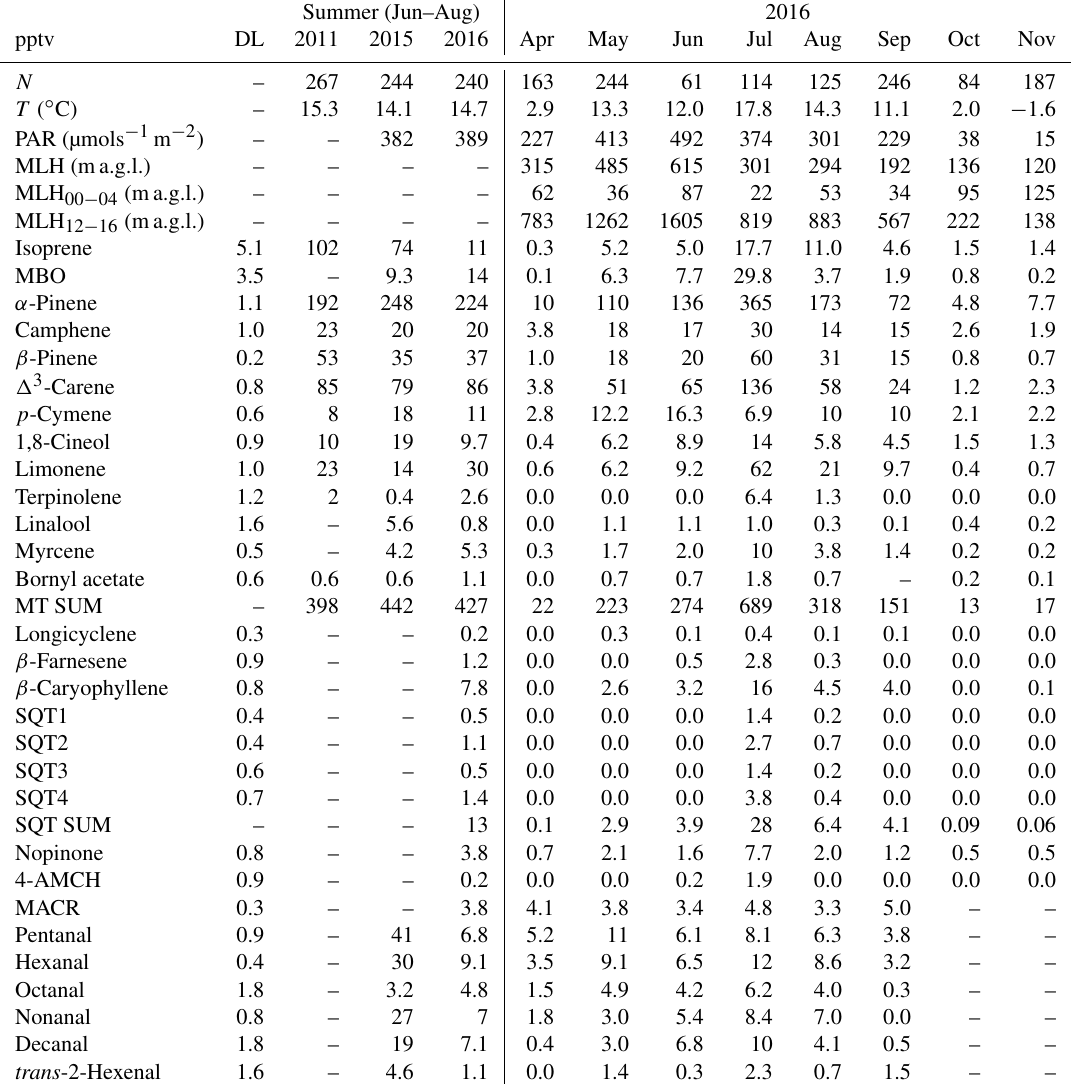
Table 1. Mean concentrations of VOCs measured in summer (June–August) in 2011, 2015 and 2016 (GC-MS1 and GC-MS3) and monthly mean concentrations (pptv) in April–November 2016 with mean temperature ( T ), mean photosynthetically active radiation (PAR), mean mixing layer height (MLH), mean MLH between 00:00 and 04:00 (MLH 00 − 04 , local wintertime UTC + 2), and mean MLH between 12:00 and 16:00 (MLH 12 − 16 ) during the VOC measurements. N : number of measurements; DL: detection limit; “–” indicates a missing value.